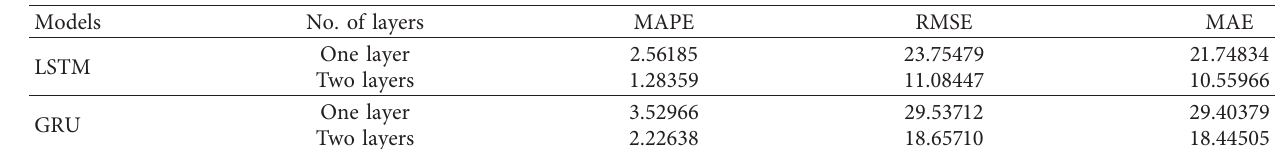
Table 13: The results of DL for death cases in Kuwait.